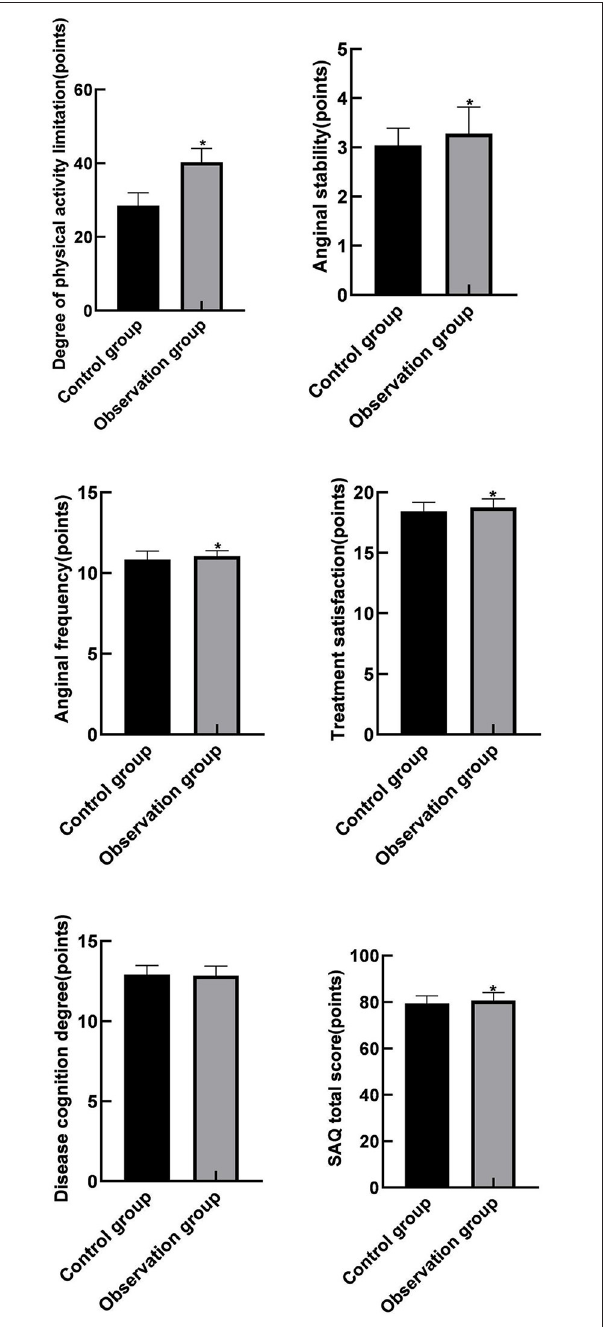
FIGURE 2 | Comparison of SAQ scores between the two groups. Compared with the control group, * P < 0.05.